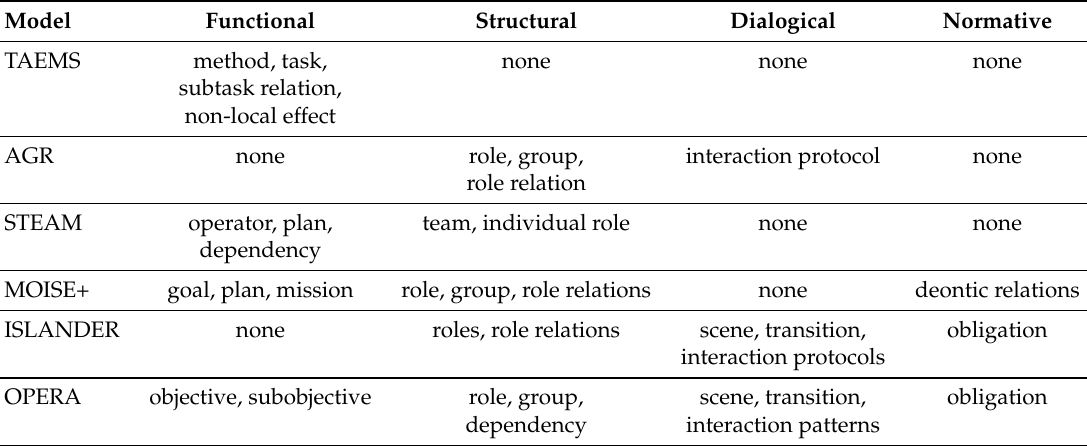
Table 1. Organizational models